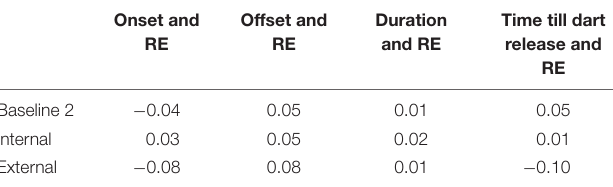
RE, radial error, measured in cm; QE, quiet eye, all QE data were measured in